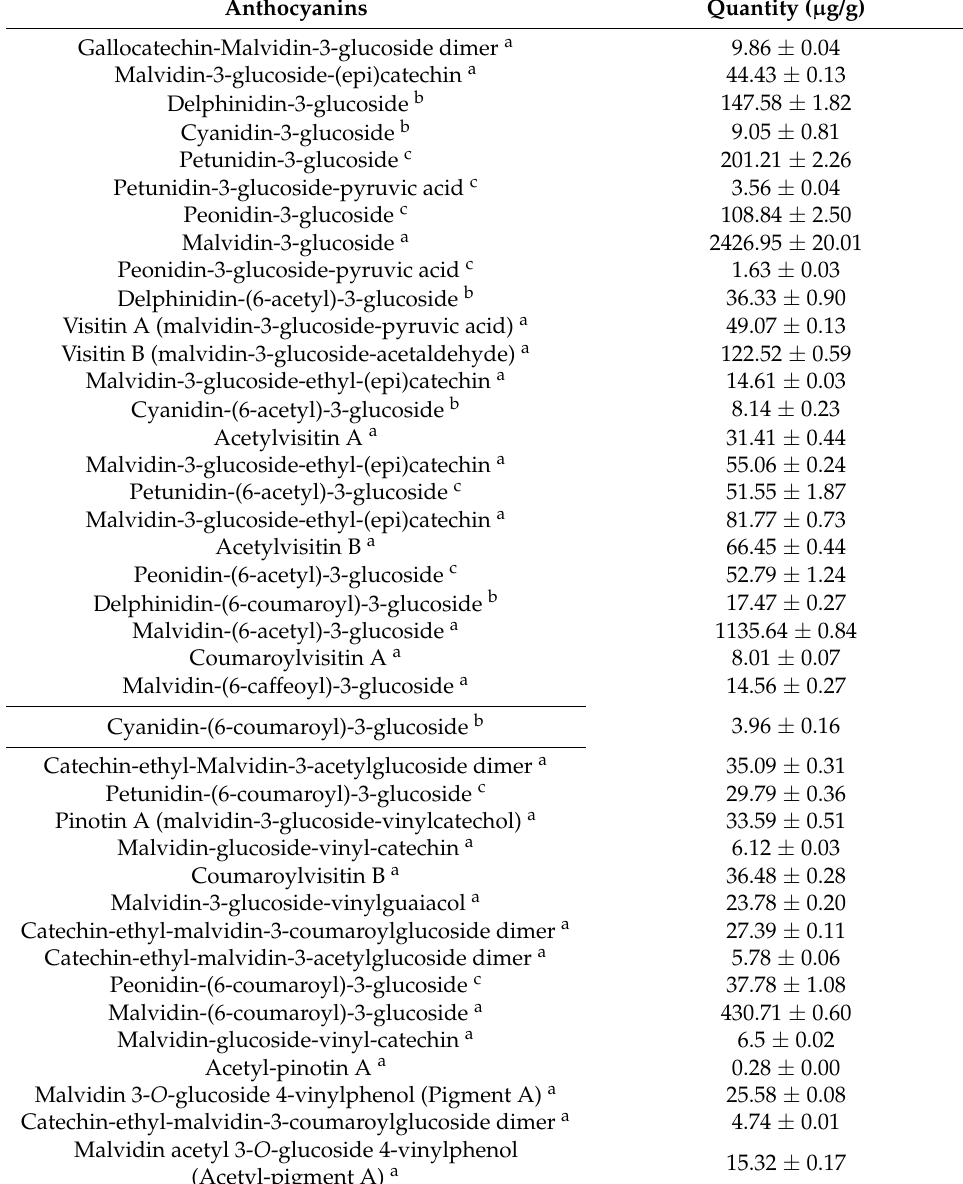
Table 3. Anthocyanins found in wine lees powder by